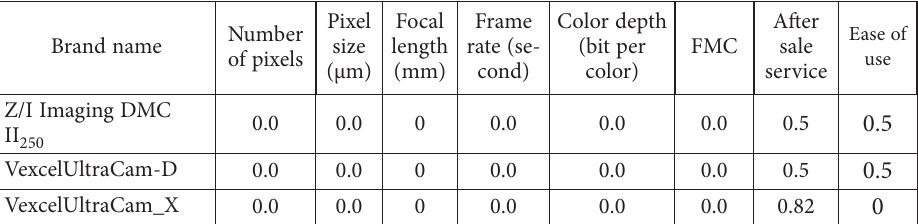
Table 8. Variance function matrix of camera